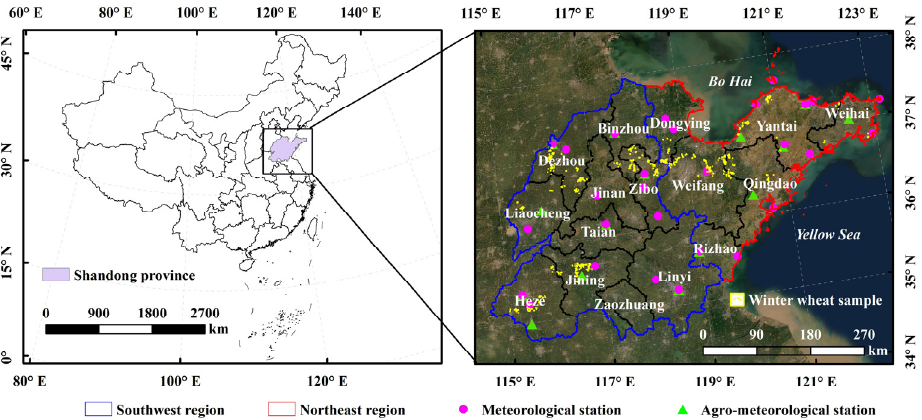
Figure 1. Location, subregion, winter wheat sample, meteorological station, and agro-meteorological station of Shandong Province.